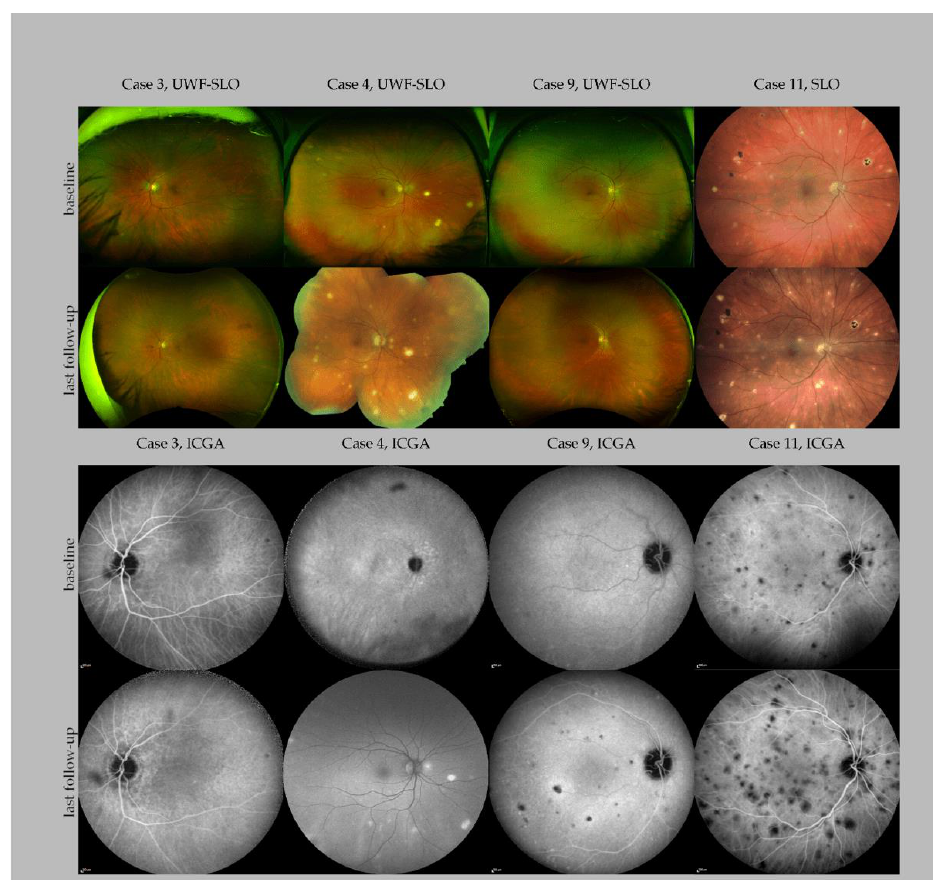
Figure 1. Multimodal imaging of four patients with Mycobacterium chimaera infection. The panel showcases baseline and last follow-up imaging of four patients with different disease courses. Case 3 presented without extensive chorioretinal lesions at baseline and never developed more than solitary lesions. Case 4 presented with multiple lesions at baseline and developed widespread chorioretinal lesions at his last follow-up, 36 months after baseline, shortly before his death. A follow-up of ICG could not be performed; a fundus autofluorescence image is shown instead. Case 9 presented with solitary lesions at baseline and developed extensive chorioretinal lesions 47 months after follow-up. Note that some of the lesions are pigmented. Abbreviations: UWF: Ultra widefield; SLO: scanning laser ophthalmoscopy; ICGA: indocyanine green angiography.